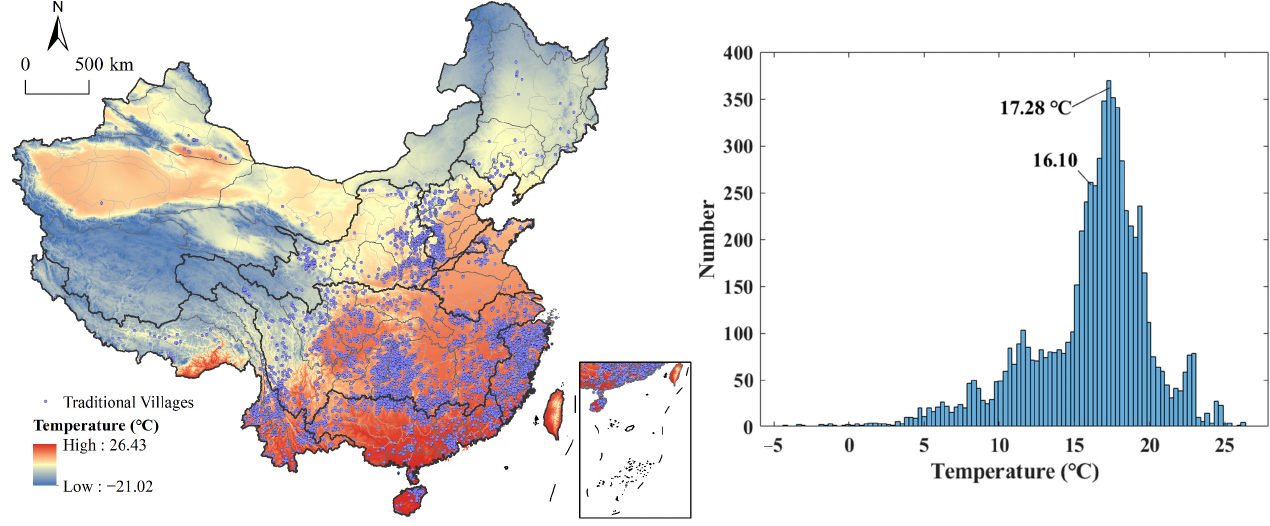
Figure 5. Relationships between traditional villages and annual average temperature in China.